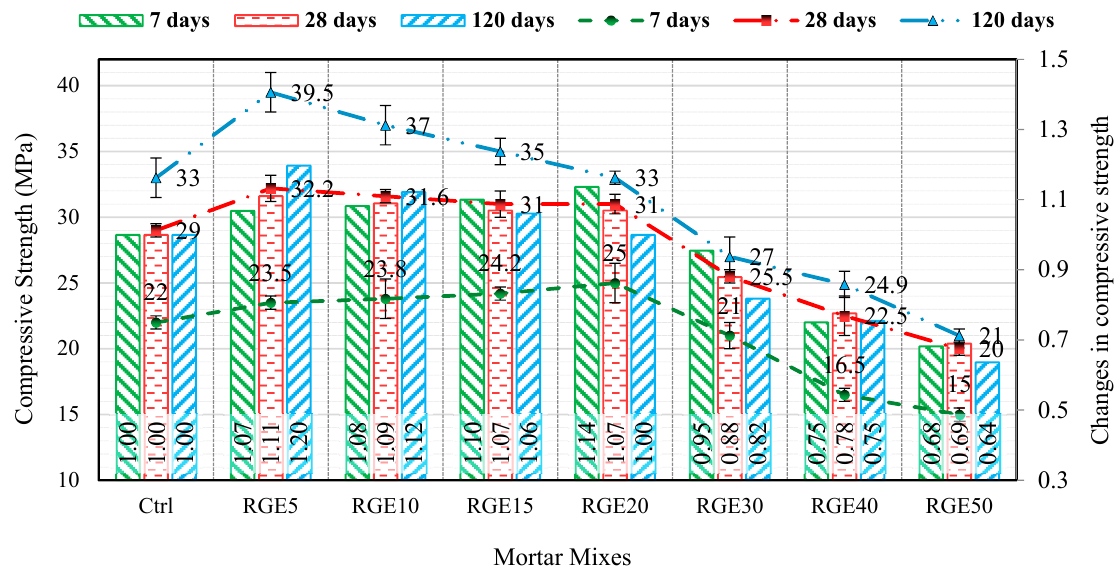
Figure 7. Compressive strengths at 7, 28, and 120 days.